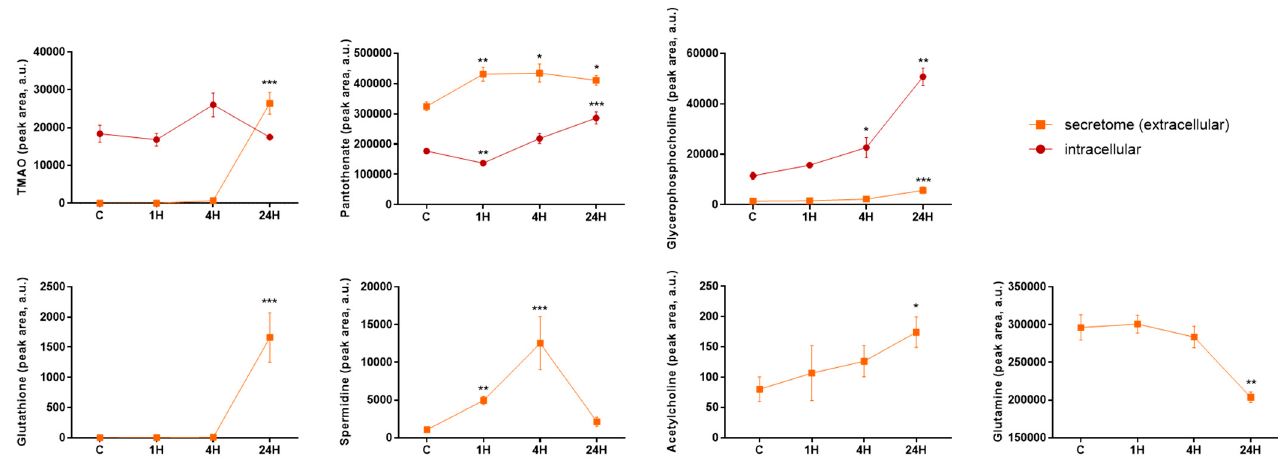
Figure 3. Intracellular and extracellular metabolic content of HA-VSMCs exposed to pro-atherogenic stimulus. Metabolites were extracted from HA-VSMCs and from the secreted media after 1 h, 4 h and 24 h following stimulation. Statistical significance was calculated for every time point versus control group (C). * p value < 0.05, ** p value < 0.01, *** p value < 0.001.